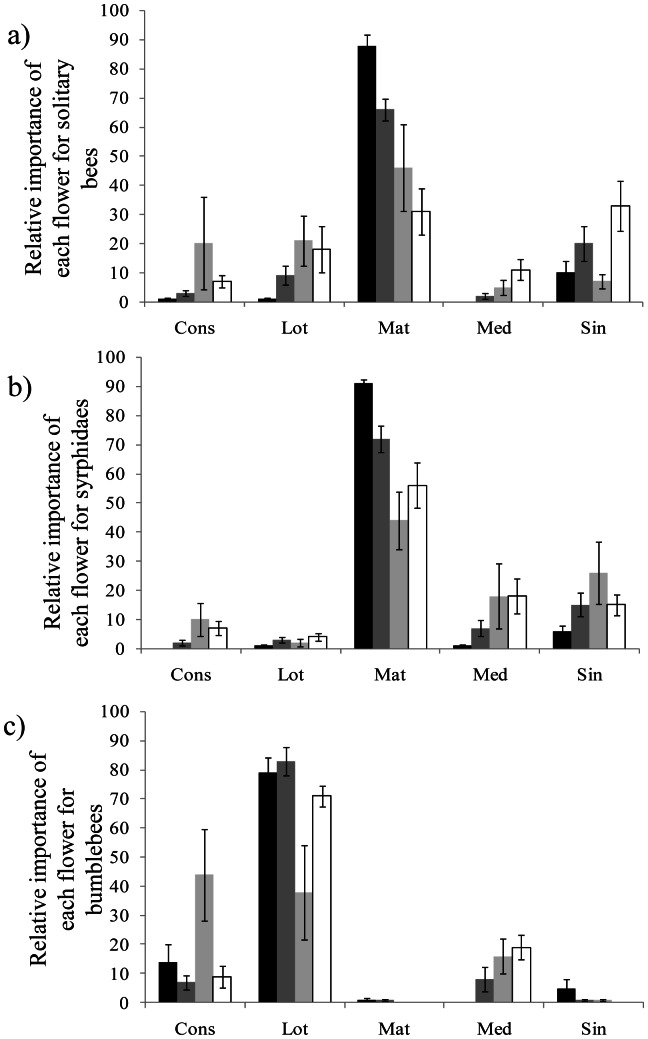
Mean number of visits per plant species for 3 pollinator morphotypes according to landscape contexts.Cons: C. regalis; Lot: L. corniculatus; Mat: M.inodora; Med: M. sativa. Sin: S. arvensis. Black bars: semi-natural context; dark grey bars: agricultural context; light grey bars: suburban context; white bars: urban context. Lines above bars denote 95% confidence interval.